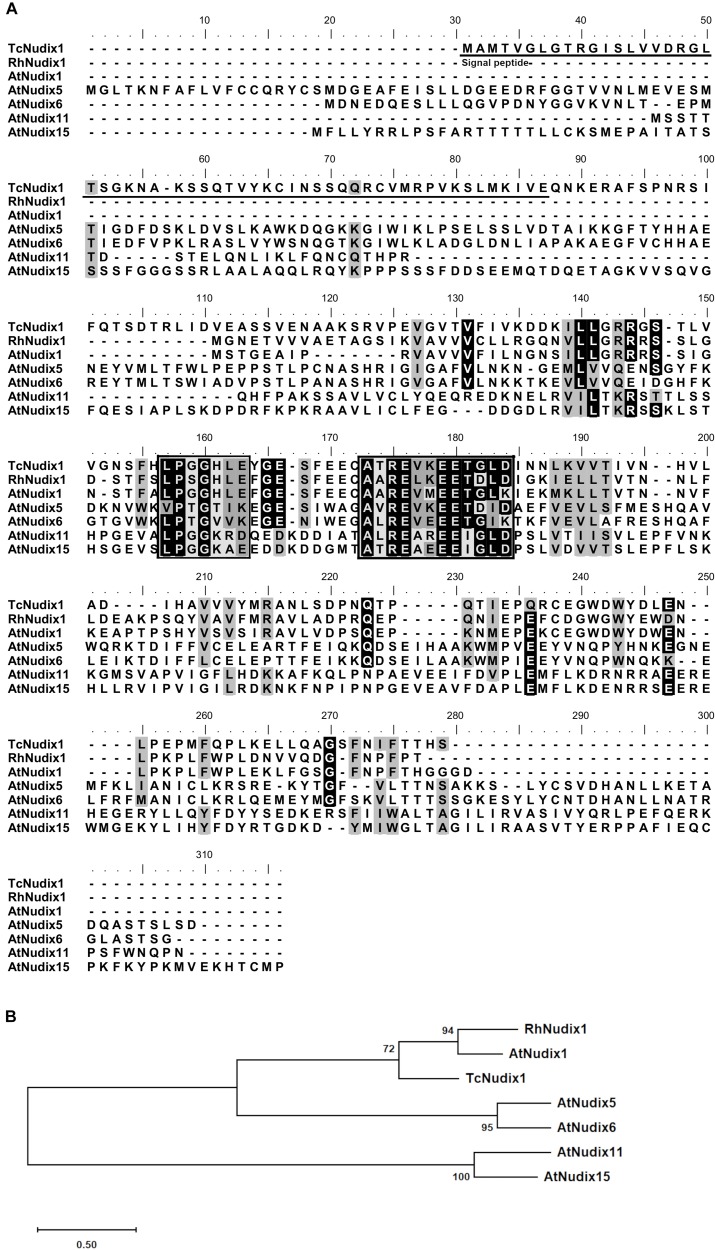
Sequence comparisons of TcNudix1, RhNudix1, AtNudix1, AtNudix2, AtNudix5, AtNudix6, AtNudix11, and AtNudix15. (A) Sequence alignment of TcNudix1 and related sequences. Alignment was conducted by ClustalW alignment BioEdit. Black background indicates amino acid identity between sequences and gray background represents amino acid similarity (Threshhold of shading = 60%). The predicted plastid signal peptide of TcNudix1 is underlined. Two boxes show the consensus motifs. (B) Maximum-likelihood phylogenetic tree of sequences. RhNudix1 and AtNudix1 were reported to hydrolyze prenyl diphosphate (GPP for RhNudix1 and DMAPP and IPP for AtNudix1). AtNudix11 showed no activity with several prenyl diphosphates but its substrate has not yet been identified (Schilmiller et al., 2012; Henry et al., 2018). No biochemical characterizations of AtNudix2 and AtNudix15 have been performed (Schilmiller et al., 2012; Li J. et al., 2019; Zhou and Pichersky, 2020).